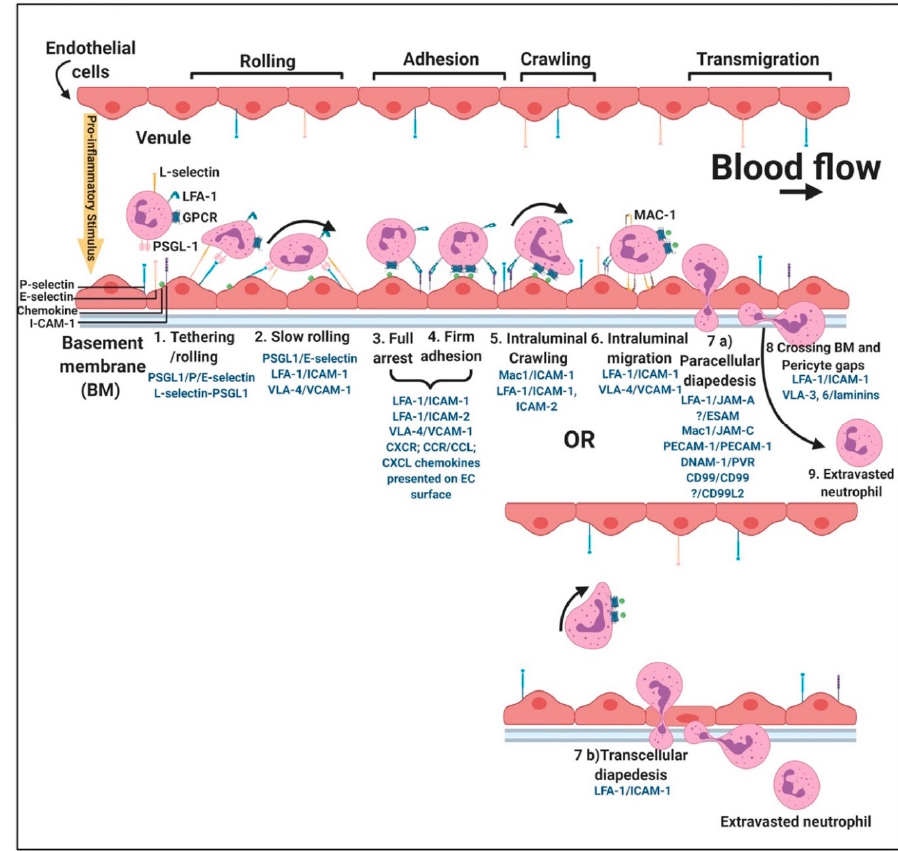
Figure 9. Simplified leukocyte extravasation cascade and rolling of neutrophils over the endothelium: adjusted from [102,147–150]. For more detail, under each step, the known adhesion receptor interactions are given with the leukocyte receptor being named first. Unknown ligands are indicated with question marks. Abbreviations: GPCR- G-protein coupled receptor, LFA-1, lymphocyte function-associated antigen 1; PSGL-1, P-selectin glycoprotein ligand-1; I-CAM-1, intercellular adhesion molecule 1. Figure created using BioRender (https: // biorender.com /